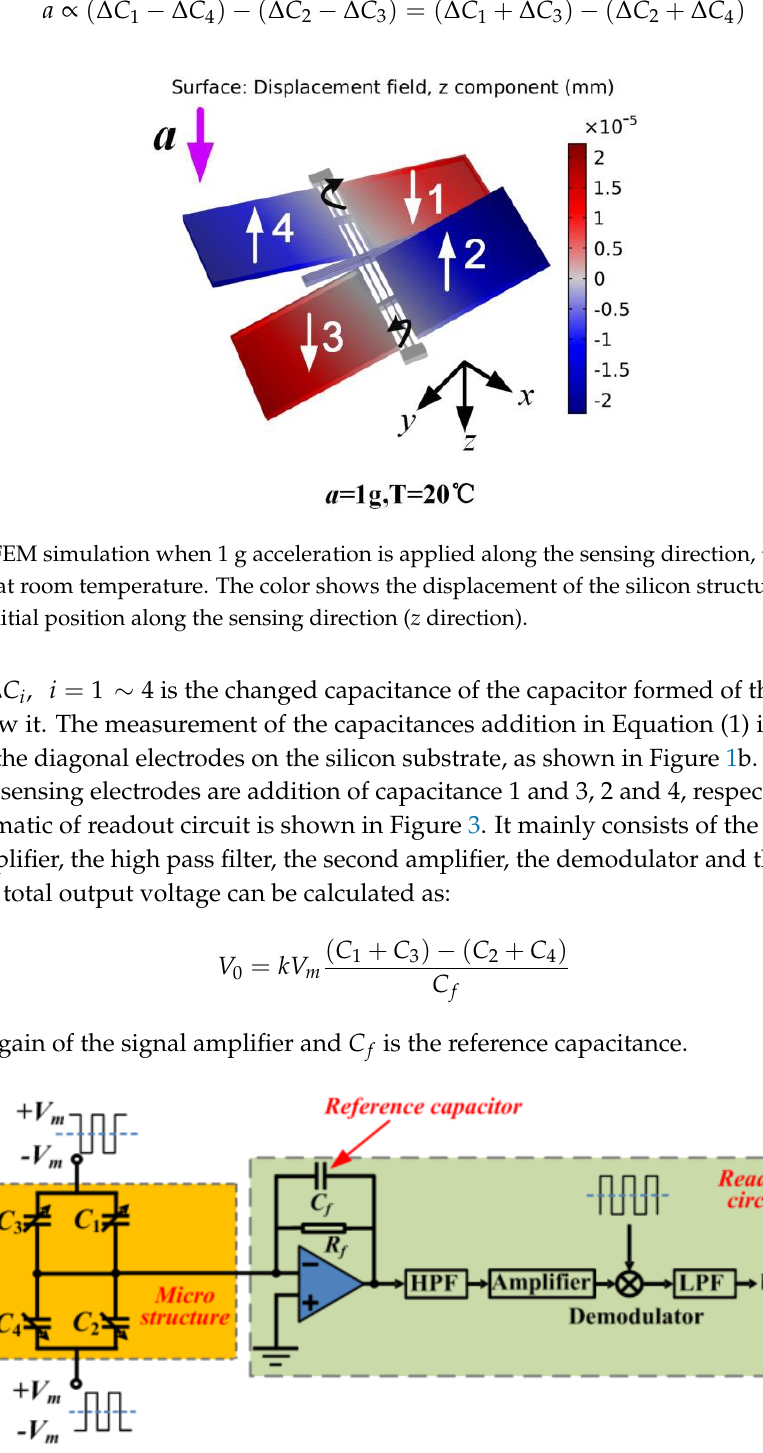
Figure 3. Schematic of the readout circuit.